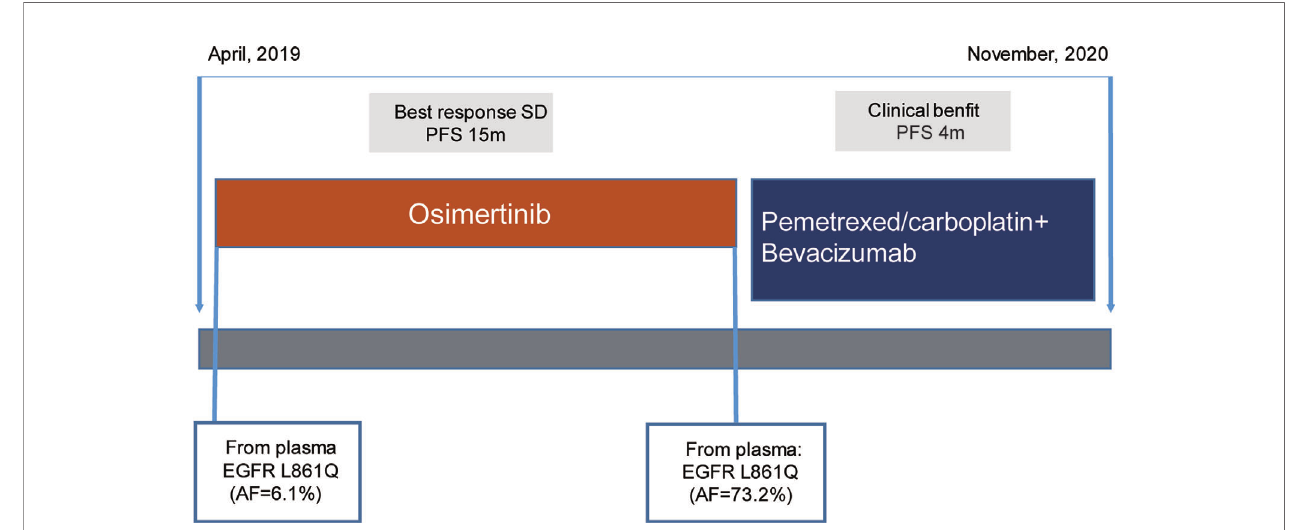
FIGURE 3 | Schematic of the course of disease management, showing different treatment regimens prescribed and the results of the mutation